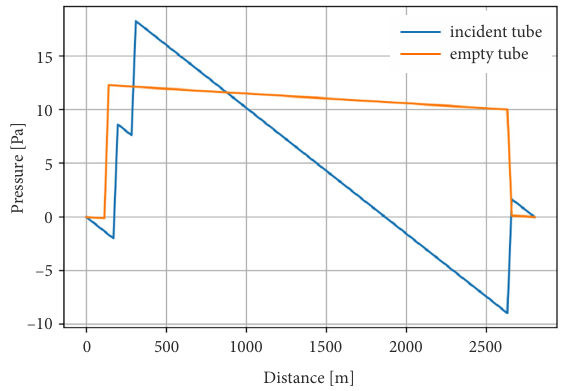
Figure 18. Pressure distribution during the incident Figure 19. Pressure differences between the tubes after